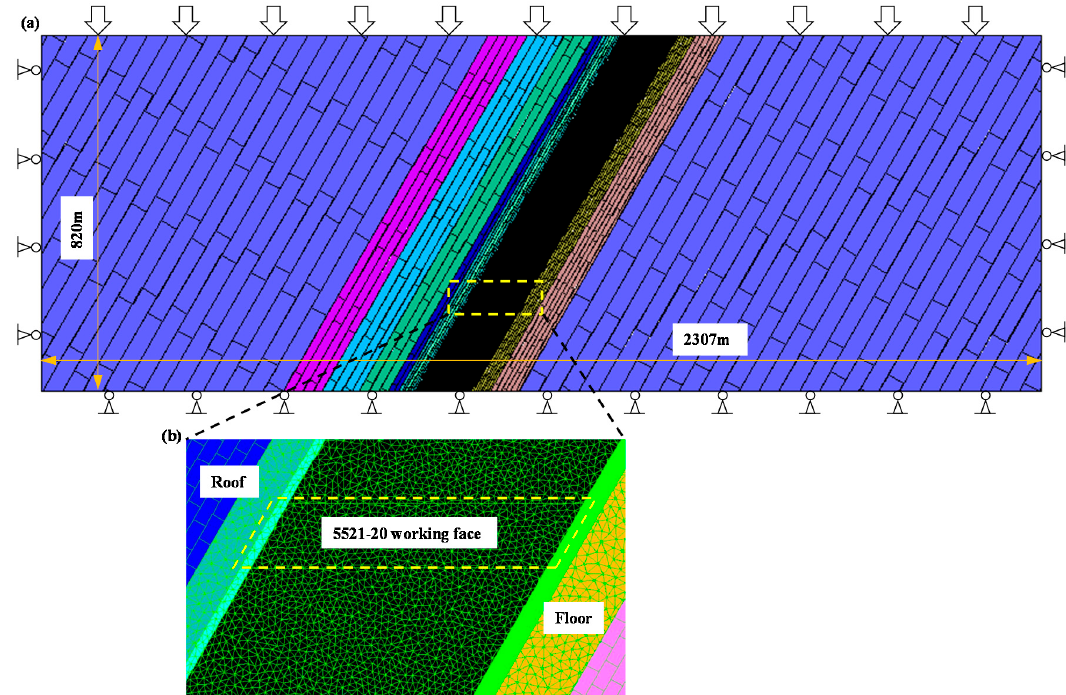
Figure 4. Model overview: ( a ) Configuration of the entire model; and ( b ) The area of interest.